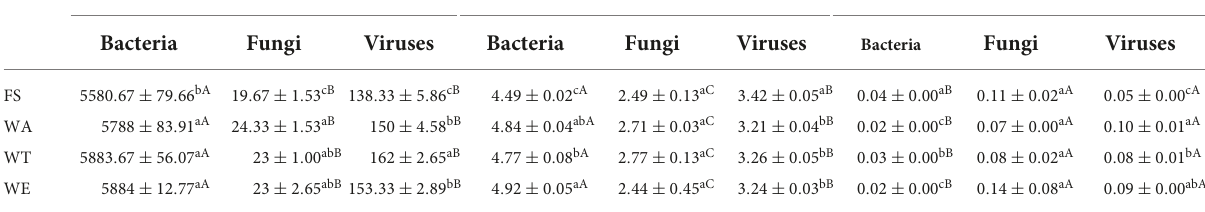
TABLE 3 Alpha diversity analysis of microbial communities.